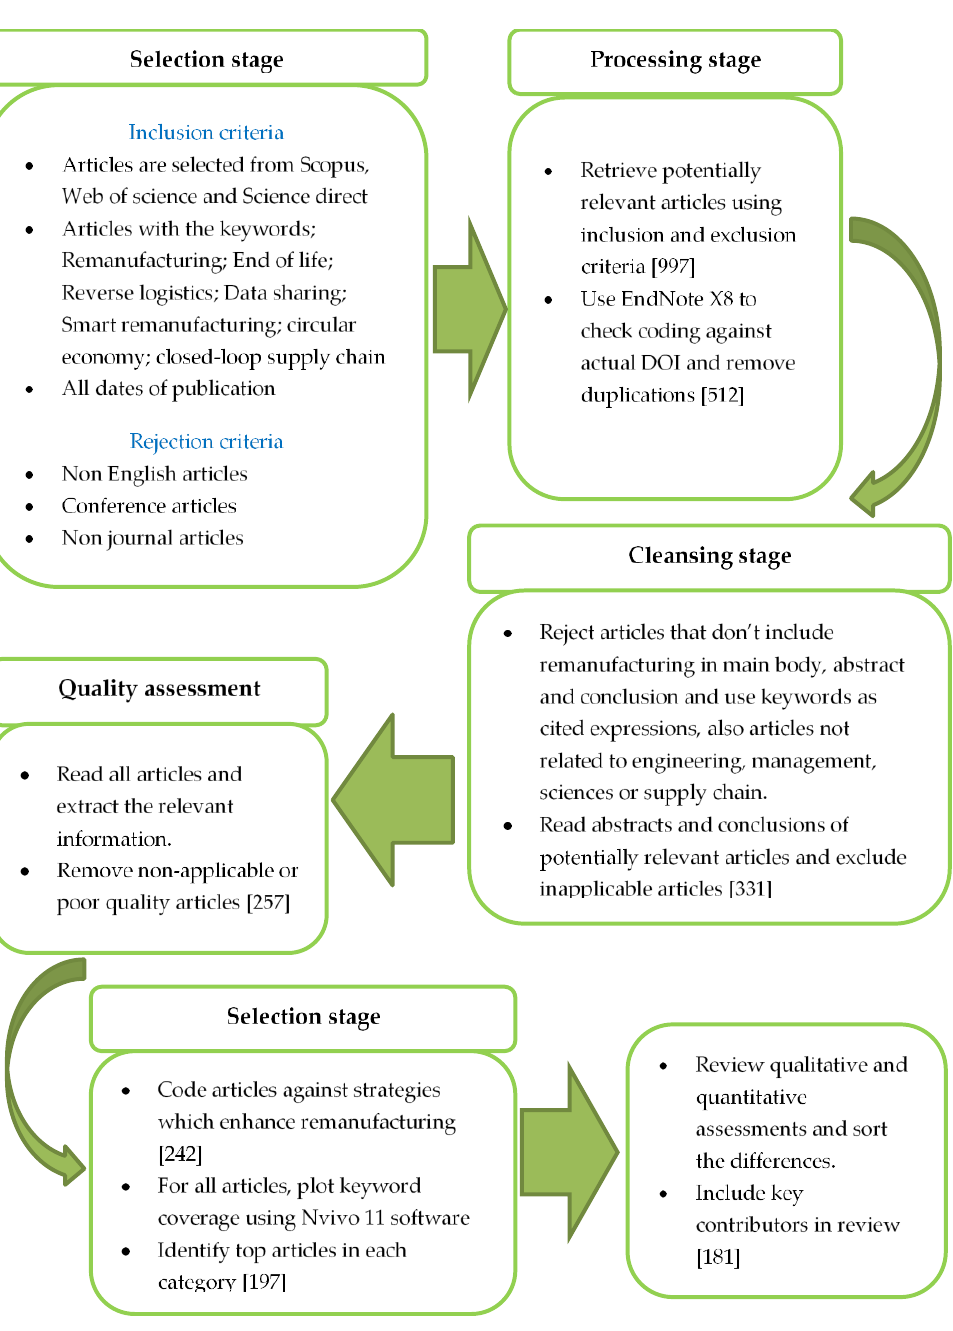
Figure 1. Literature review process.